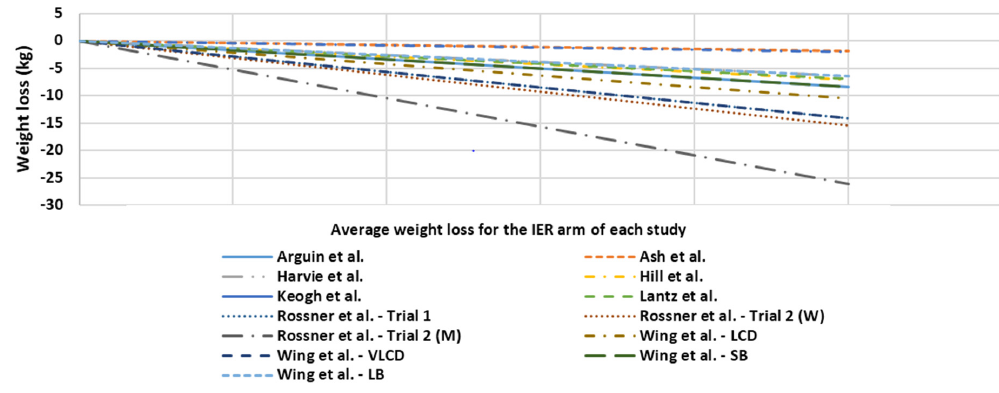
Figure 2. Average weight loss of subjects at the final data collection point for the IER arm of each study.